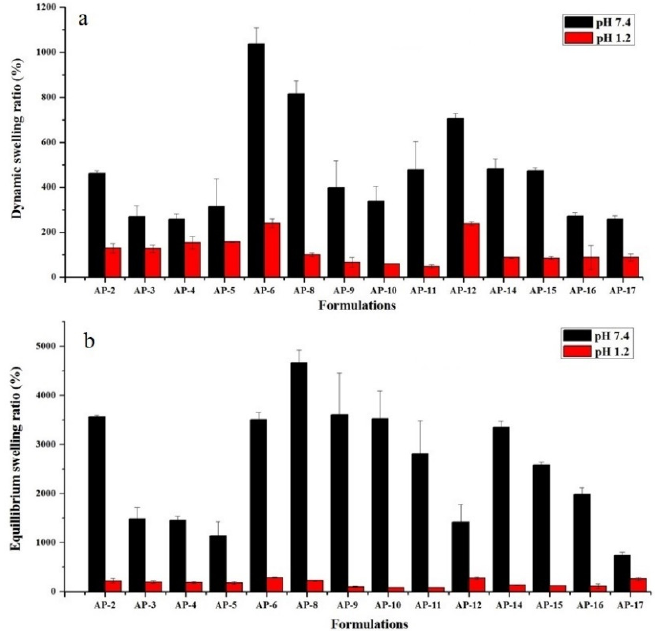
Figure 2. Effect of pH on dynamic swelling ratio (%) at 8 h ( a ) and equilibrium swelling ratio (%) ( b ) of semi-IPN hydrogels. Error bars show standard deviation ( n = 3). No gel was formed in AP-1, AP-7, and AP-13.